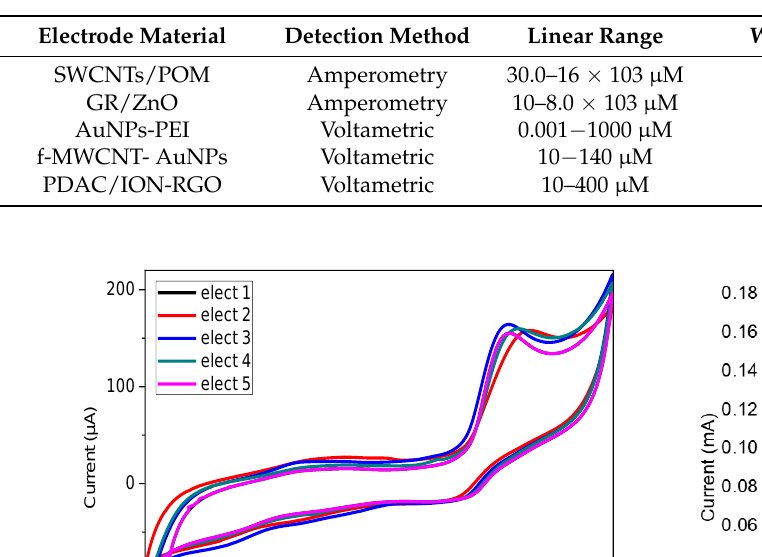
Table 1. Parameters and performances of different nitrite sensors.